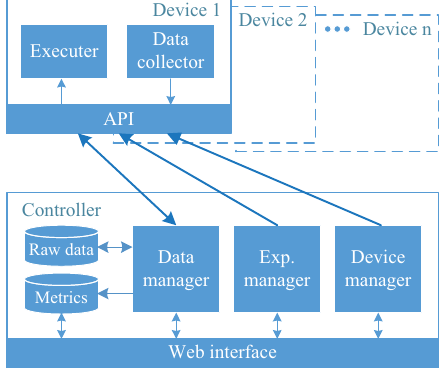
Figure 2: The implementation details of the testbed.